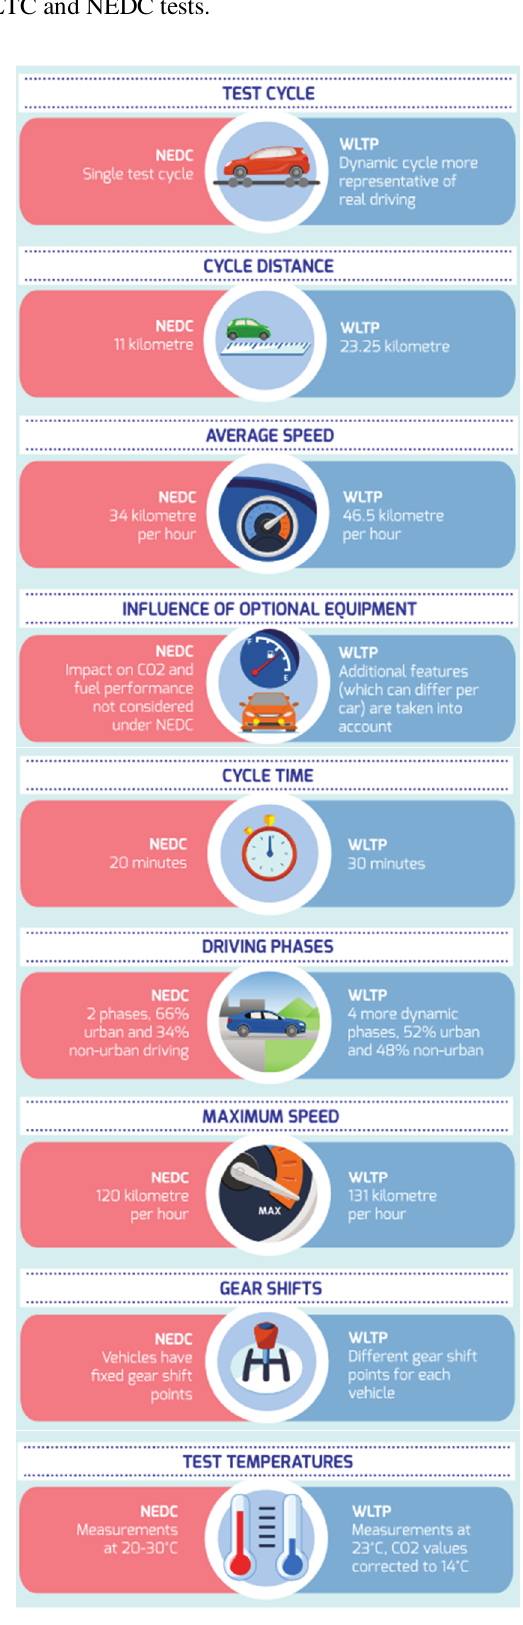
Fig. 3. Differences between NEDC and WLTC